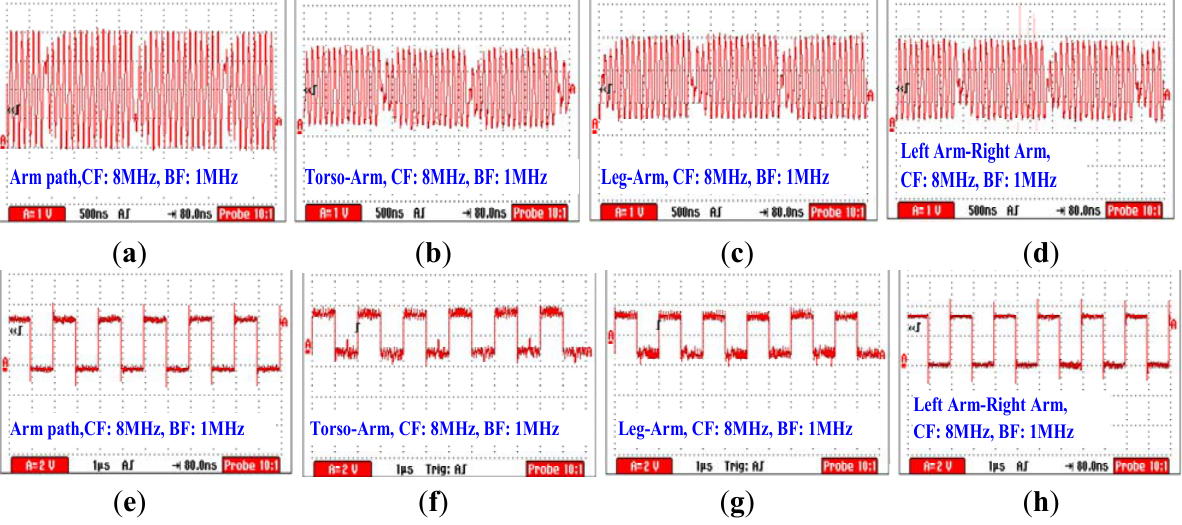
Figure 11. The modulated signal and the corresponding demodulated signal with respect to the four signal transmission paths (arm path, torso-arm, leg-arm, left arm-right arm) on the conditions that CF = 8 MHz, BF = 1